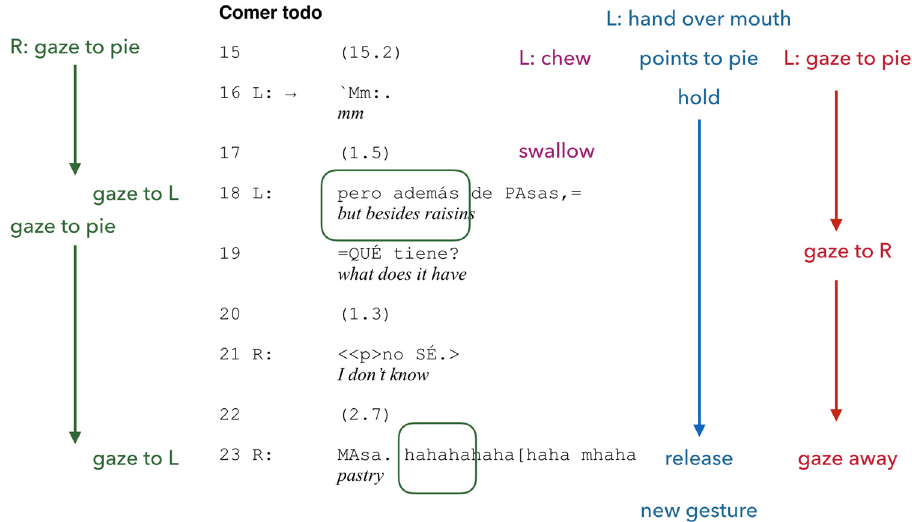
Figure 3: R ’ s gaze behaviour ( annotated left ) , alongside L ’ s gustatory, manual, and gaze behaviour ( annotated right )